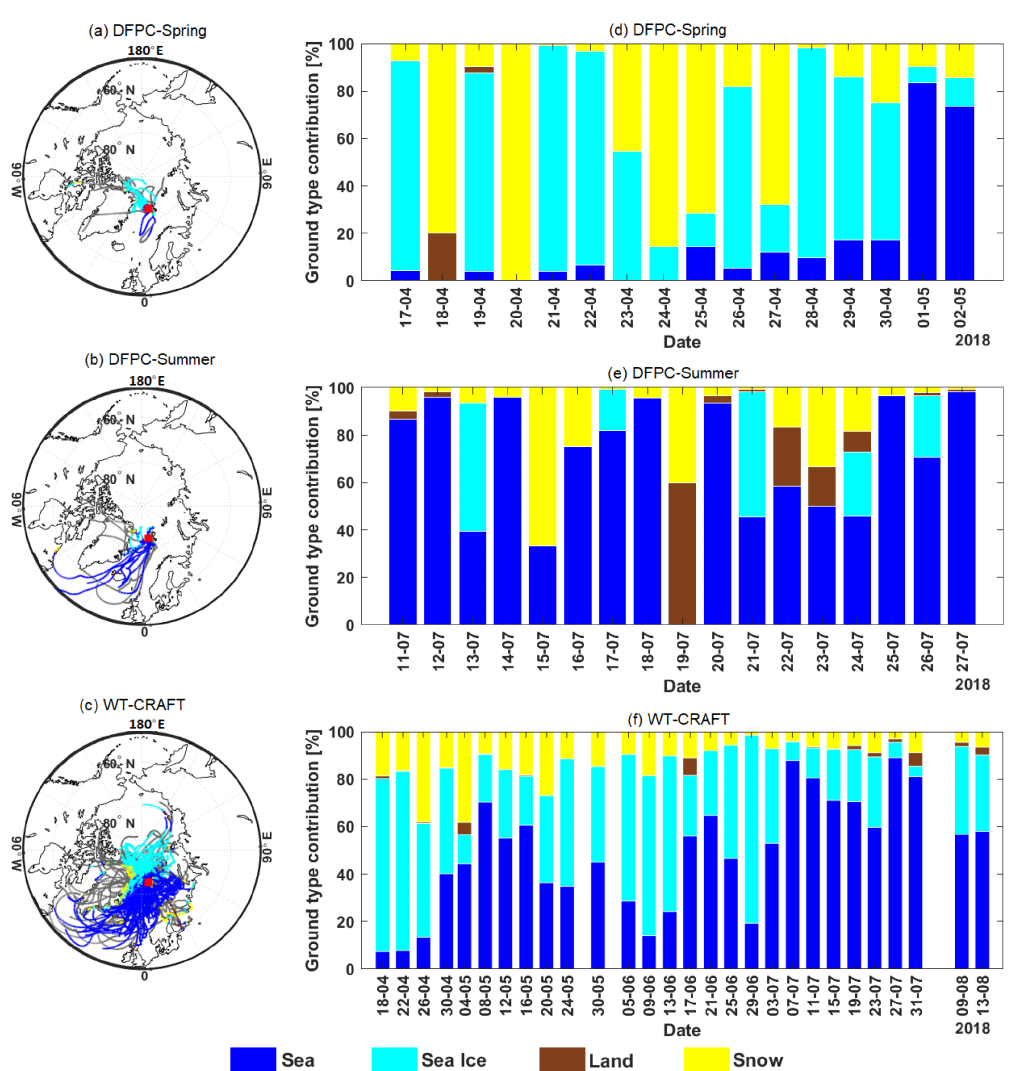
Figure 6. Air mass back-trajectories and ground-type influence on low-traveling ( < 500m) air masses for DFPC in spring (a) , DFPC in summer (b) and WT-CRAFT (c) measurements. Back-trajectories reported in grey in the maps passed above 500ma.m.s.l. and were therefore excluded from the analysis. The ground-type categories are described in Sect.